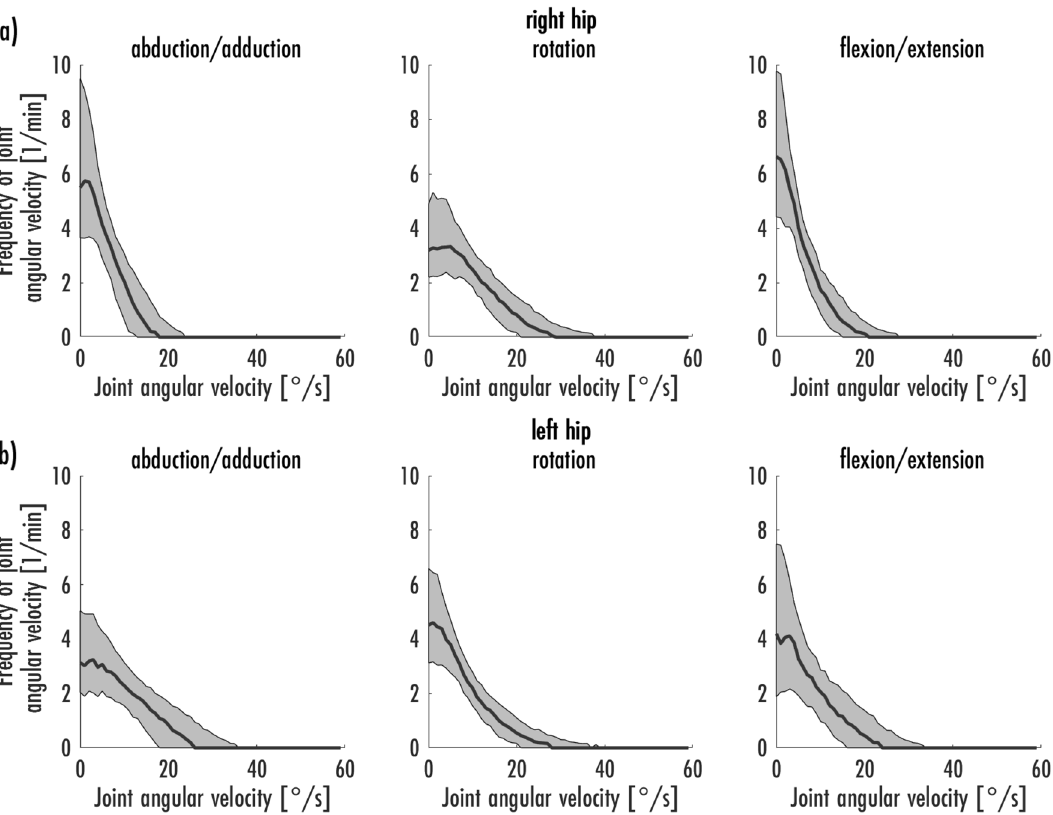
Figure 6. Frequencies of joint angular velocity [1/min] in hip joints right ( a ) and left ( b ) in habitual vacuuming [median, 25%- and